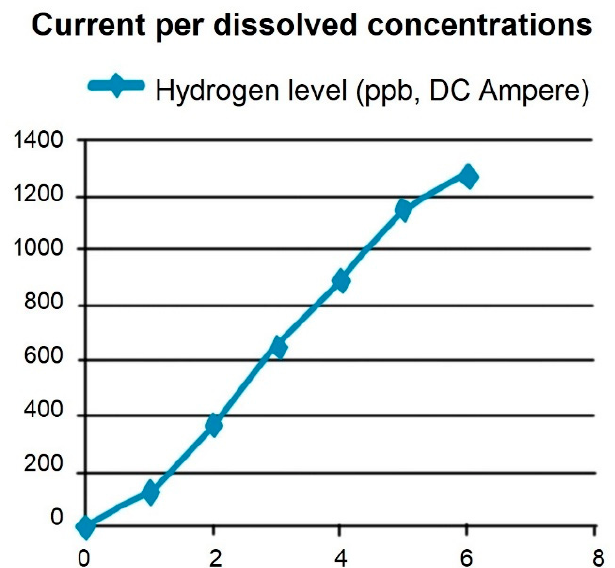
The EVOdrop Booster produces hydrogen-rich water. EVOdrop hydrogen water has a concentration of hydrogen (Figure 6).